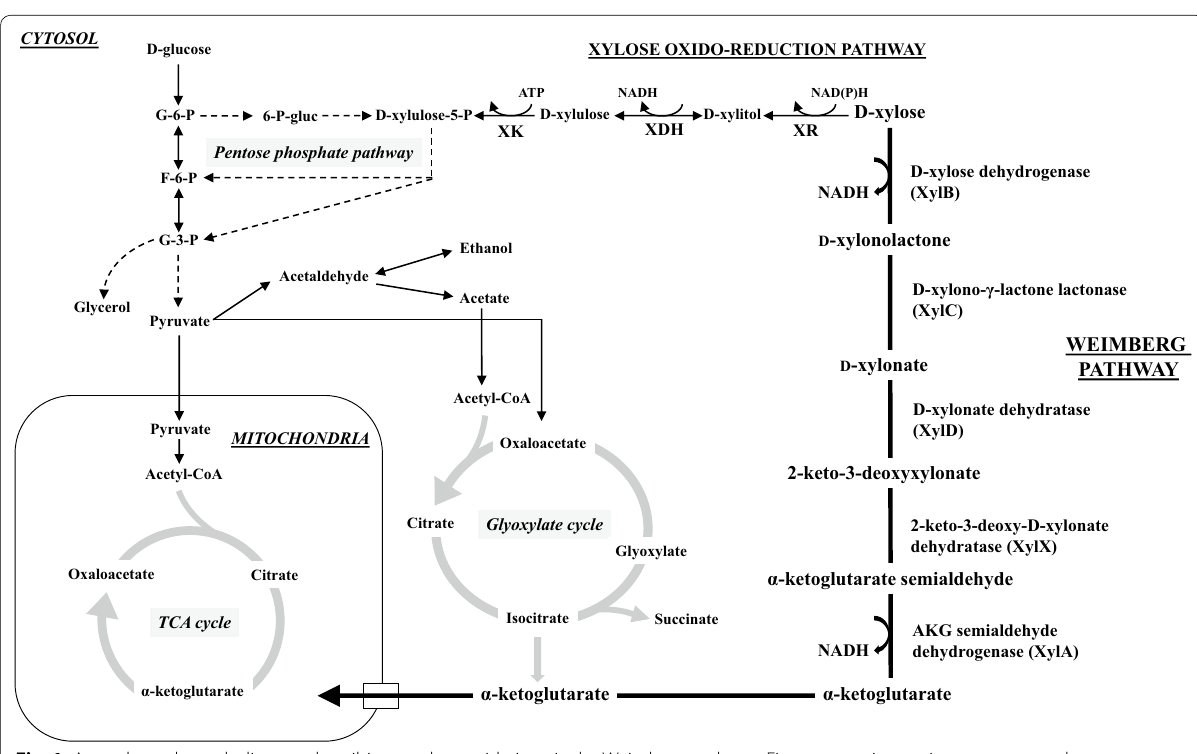
Fig. 1 A condensed metabolic map describing d ‑xylose oxidation via the Weimberg pathway. Five enzymatic reactions convert d ‑xylose to α‑ketoglutarate that enter the central cellular metabolism via the TCA cycle. For comparison, the oxido‑reduction of d ‑xylose to d ‑xylulose through the oxido‑reduction pathway (XR/XDH) is also shown. Required cofactors (ATP, NADH or NADPH) are indicated for the two xylose pathways while the central cellular metabolism is presented in a simplified scheme. XR xylose reductase, XDH xylitol dehydrogenase, XK xylulose kinase, TCA cycle tricarboxylic acid